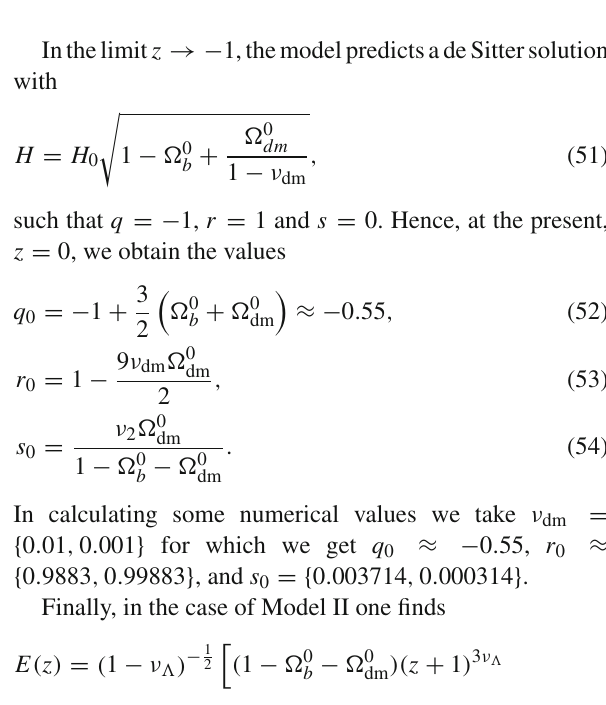
Fig. 1 The figures show the parameterspace q − r and s − r for the two first models. To show the impact of the parameter ν i = { ν dm ,ν (cid:2) } , we compute the functions for two different values of it, i.e.: (ii) ν i = 0 . 01 (first column), and finally (iii) ν i = 0 . 001 (second column). In addition,